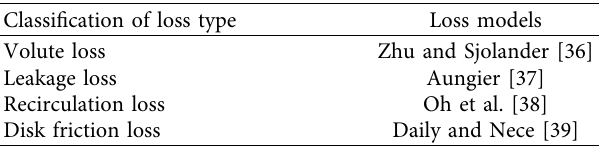
Table 3: List of adopted loss